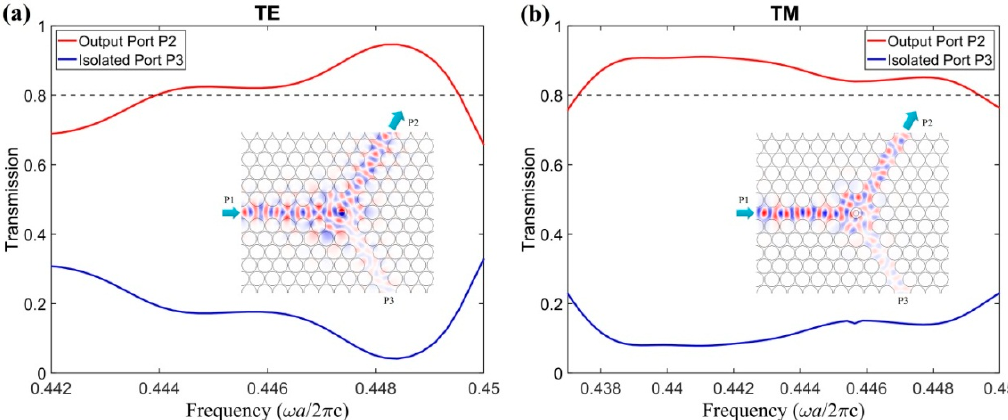
Figure 5. Frequency scans on transmissions of output port P2 and isolated port P3 for ( a ) TE and ( b ) TM polarization. The